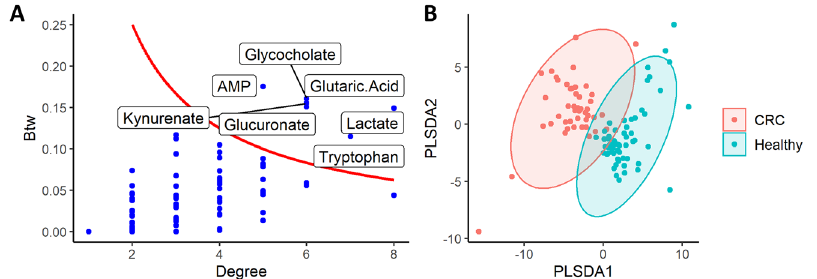
Figure 2: In panel (A), the importance of nodes preserved in the differential network’s backbone between CRC and healthy subjects, characterized by betweenness centrality (Btw, y -axis) and node degree ( x -axis). Key nodes with high degrees and high betweenness (degree ∗ betweenness > 0.5) were labelled with their metabolite names. In panel (B), scores plot of PLS-DA classification model between CRC subjects and healthy